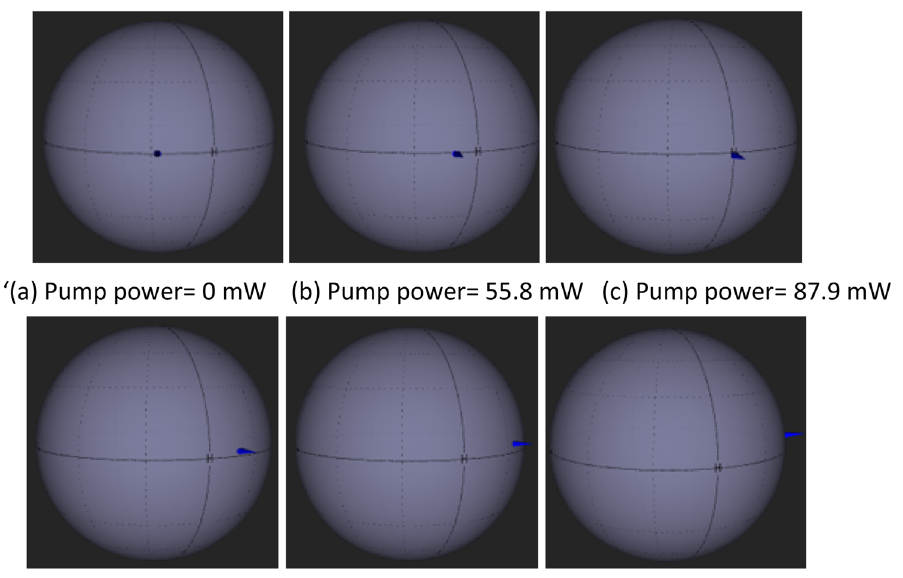
Figure 5. Evolution of Light polarization state rotation at various pump powers in 3D spherical view ( a ) 0 mW ( b ) 55.8 mW ( c ) 87.9 mW ( d ) 119 mW ( e ) 150 mW ( f ) 223 mW.